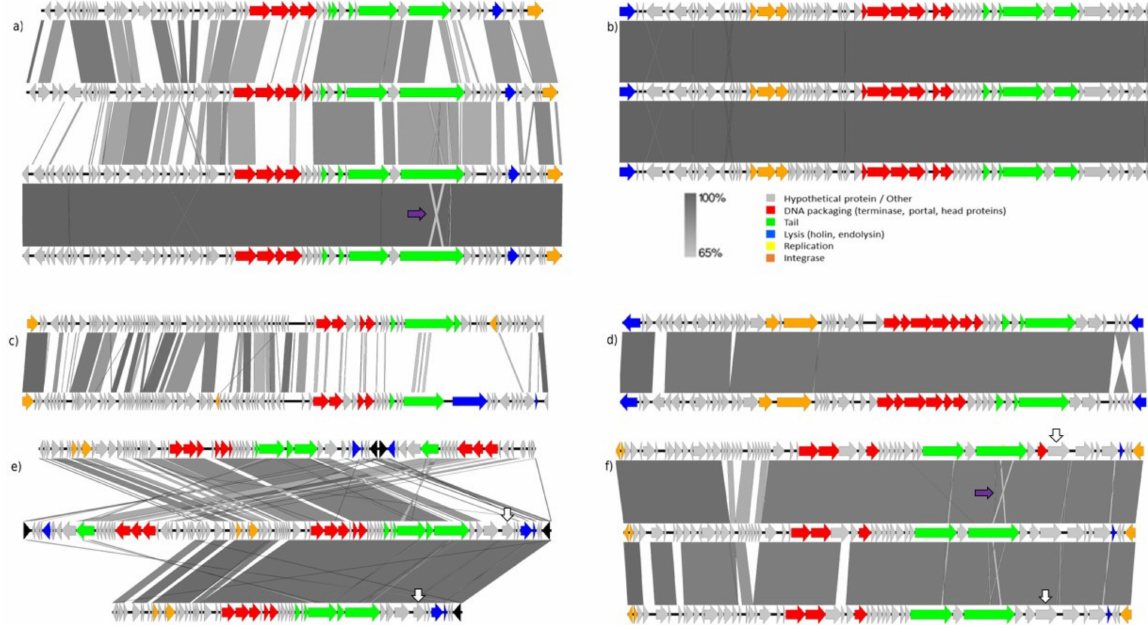
Figure 4. Bifidoprophage genomic comparison and characterisation by Easyfig. Each arrow indicates an open reading frame, orientated in the direction of transcription. The length of arrows is proportional to the the length of the predicted open reading frame. Genes predicted to have similar functions are marked with the same color. Grey arrows indicate hypothetical proteins. Genome architecture and mosaic relationships between the prophage genomes are highlighted with pairwise alignments. The colour spectrum between genomes reflects amino acid identity as shown in the percentage based legend. The prophages in each alignment are described in descending order according to the above representations and are described further in the accompanying text. ( a ) Bre215W447aph1, BreDRBB30ph3, BadTF06-29ph2 and Bad11ph1. ( b ) BifBIOML-A4ph1, BifBIOML-A6ph1 and BifBIOML-A8ph1. ( c ) BlongATCC15697ph1 (from B. longum subsp. infantis ) and BlongTF06-12ACph1 (from B. longum subsp. longum ). ( d ) Bre139W423ph1 and BlongCECT7210ph3. ( e ) Bif85Bph3, BreDRBB30ph2 and BreLMC520ph1. ( f ) BlongAF05-2ph1 (from B. longum subsp. longum ), BreDRBB29ph1 and BreBR3ph5. The purple arrows highlight sequence inversions observed in phage tail-encoding genes. The white arrows highlight reverse transcriptase encoding genes mentioned in Section